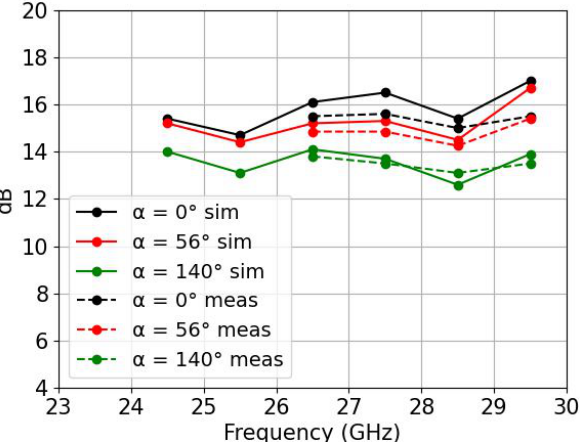
Figure 11. Realized gain over frequency for three different progressive phases, α = 0 ◦ , 56 ◦ and 140 ◦ . Values were measured only from 26.5 GHz to 29.5 GHz due to the limitations of the beamformer.